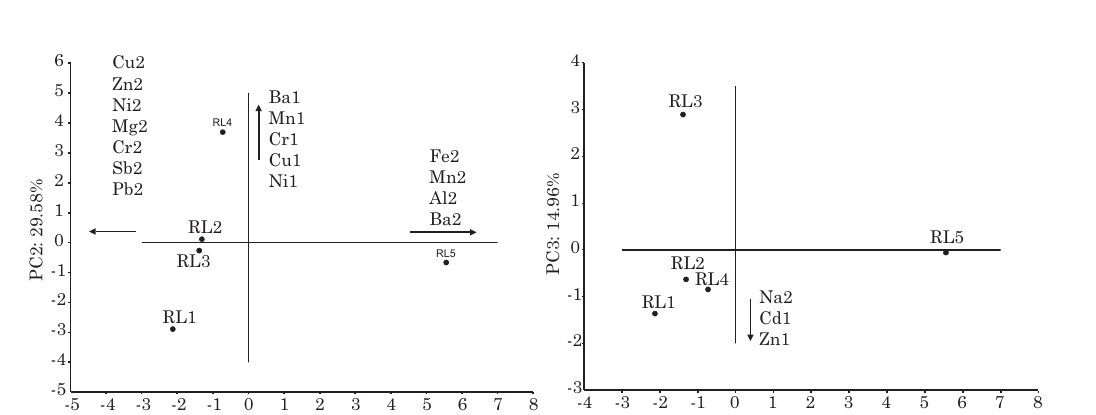
Figure 2. Scores of legal reserves obtained on major components and system variables (arrows) applied to the Pearson correlation matrix between metals of the soil samples [concentration transformed into log (x+1) to approximate normality